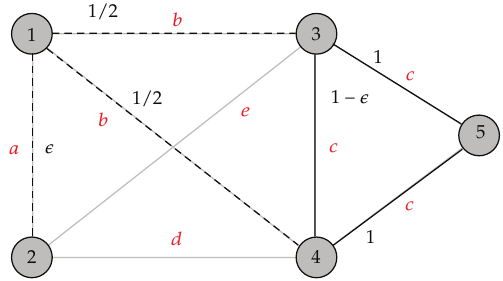
Figure 9: LP solution of EC t with objective value f lp (cid:6) 3 / 2 (cid:9) (cid:3) (cid:2) l a (cid:6) (cid:3),l b (cid:6) 1 / 2 ,l c (cid:6) 1 (cid:3) . The solution is not valid for EC tn , as the sum over the set of labels adjacent to nodes v 1 and v 2 are smaller than